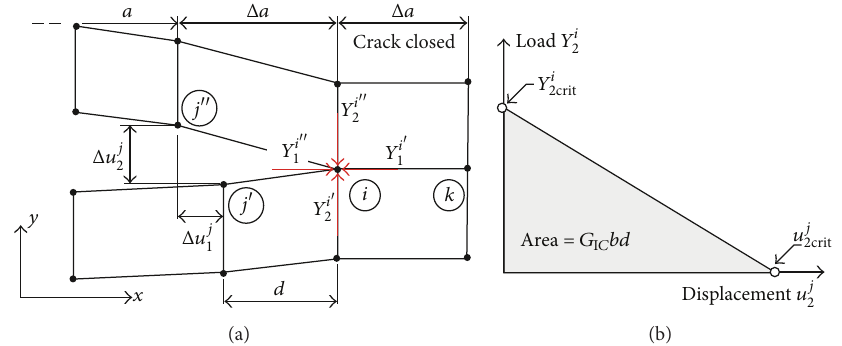
Figure 2: The VCCT: (a) for four-node elements and (b) with a crack growth criterion.